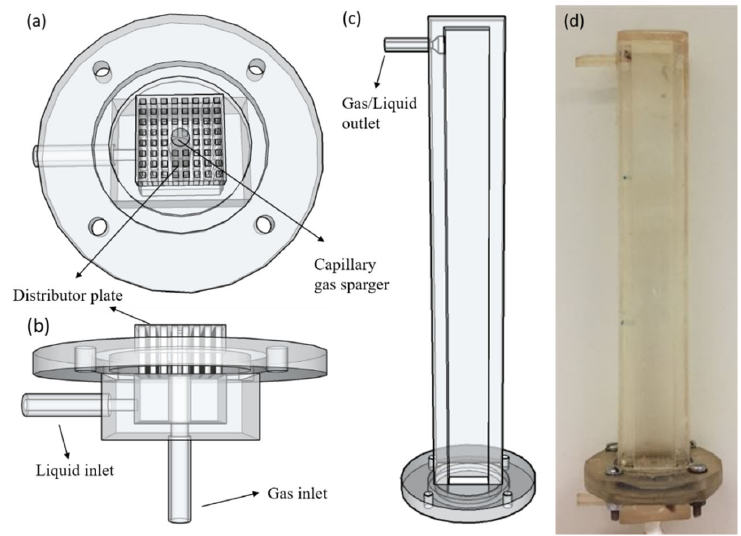
Figure 1. 3D Models of the MFB: ( a ) top view of the lower section, ( b ) front view of lower section, ( c ) upper main column with ( d ) image of the actually assembled 3D ‐ printed MFB [40] .